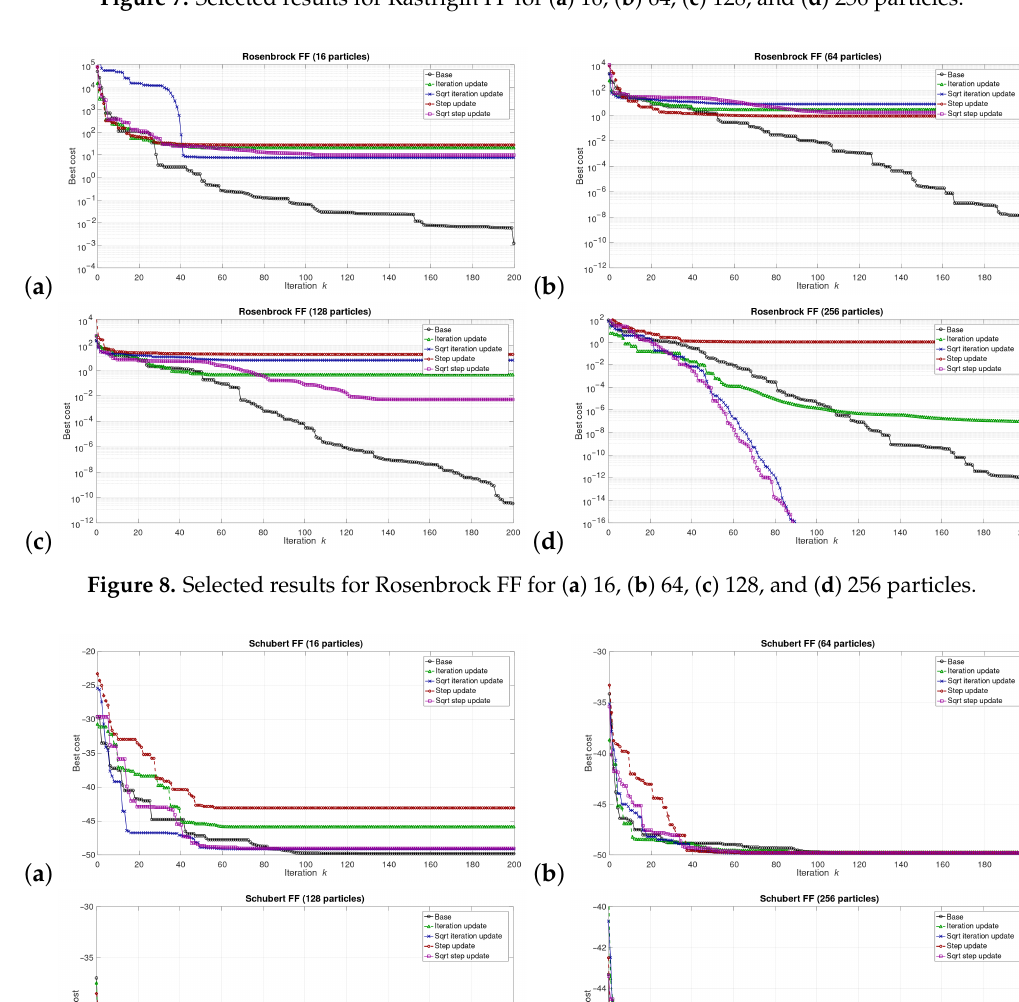
Figure 7. Selected results for Rastrigin FF for ( a ) 16, ( b ) 64, ( c ) 128, and ( d ) 256 particles.